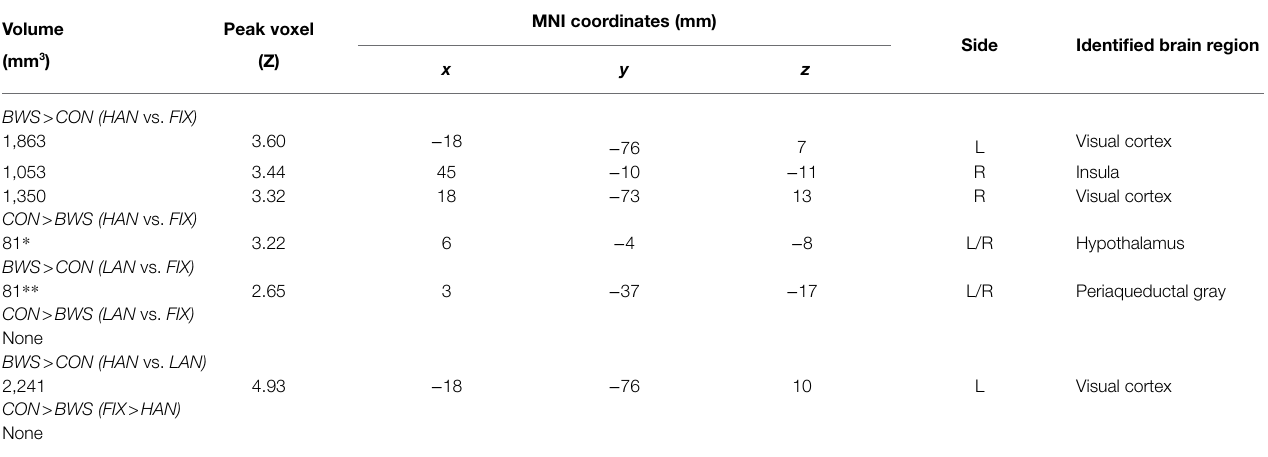
Side Identified brain region